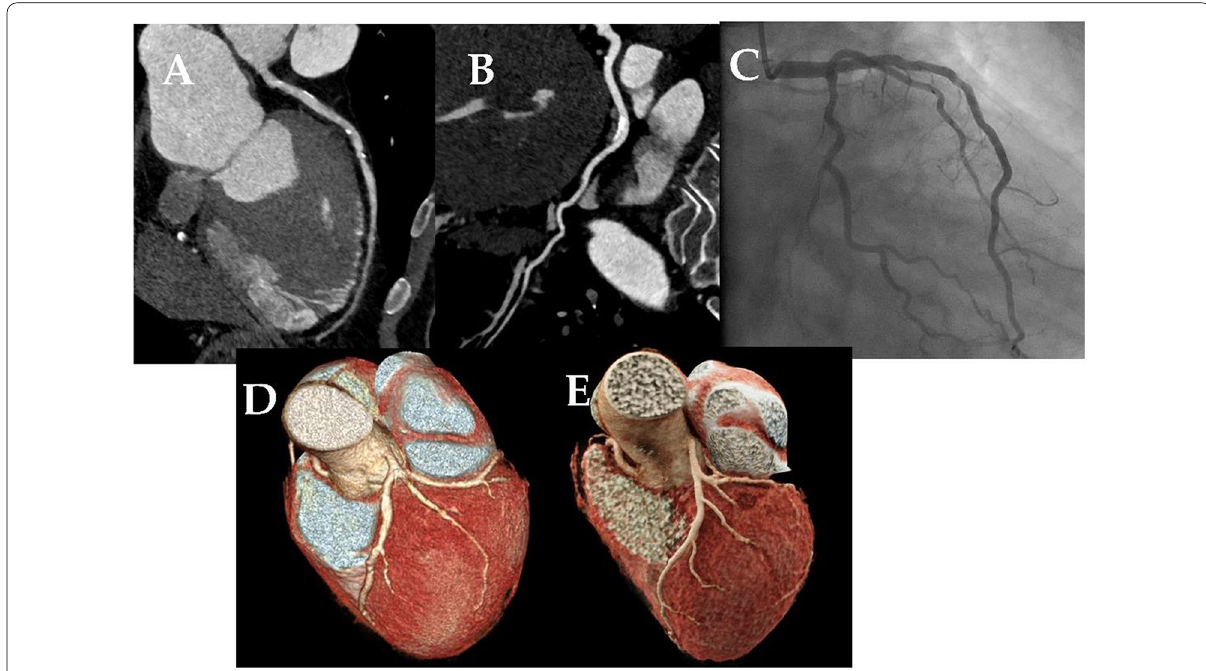
Fig. 1 Coronary CTA images from single- source CT scanner ( A , D ), and dual-source CT scanner ( B , E ), and diagnostic invasive coronary angiography image ( C